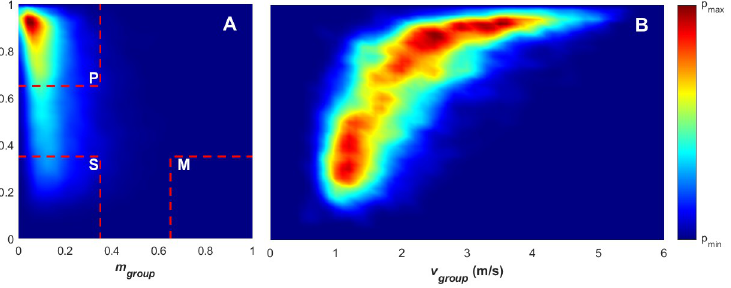
Fig 4. Density plots for polarisation, angular momentum and mean group speed. (A) Density plot for paired angular momentum ( m ) and polarisation ( p ) values, with the divisions of the order parameter space overlayed group group in red, indicating the polar (p), swarm (s), milling (m) and transitional states. (B) Density plot for paired mean group ) and polarisation ( p ) speed ( � u group group